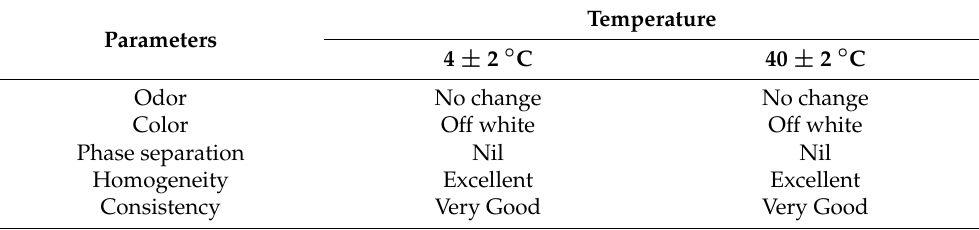
Table 2. Storage stability of NHGF4 at refrigerated and accelerated temperatures for 60 days. Parameters Odor Color Phase separation Homogeneity Excellent Excellent Consistency Very Good Very